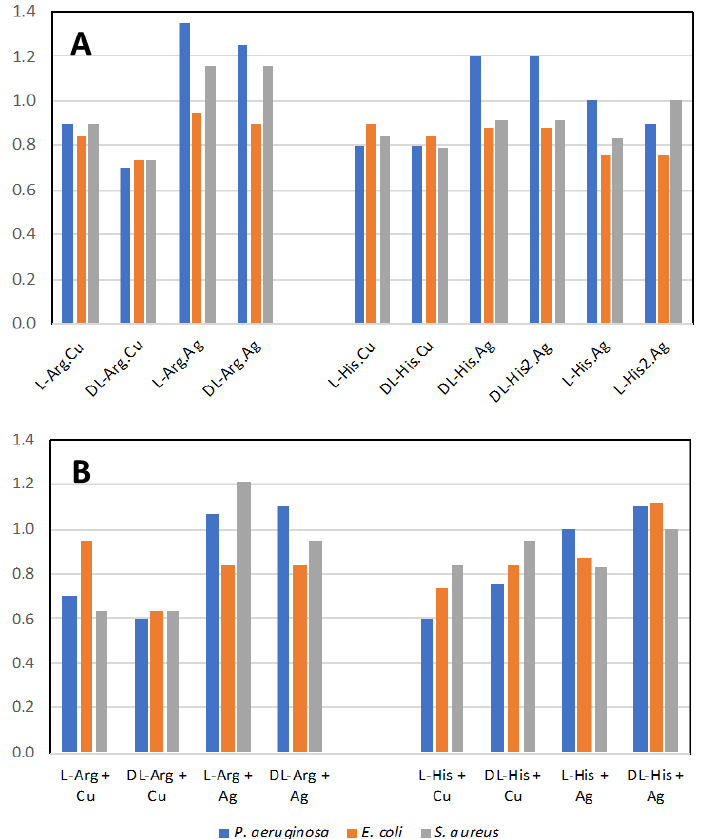
Figure 17. Antimicrobial activity. ( A ) Normalized antimicrobial activity from disk diffusion assay on lysogeny agar media for the coordination polymers of the metal salts with the amino acids; ( B ) mixture of the amino acid with the metal salt at 1:1 ratio. Values normalized to silver nitrate value of 1.0. Values above 1.05 are more antimicrobial than silver nitrate alone.